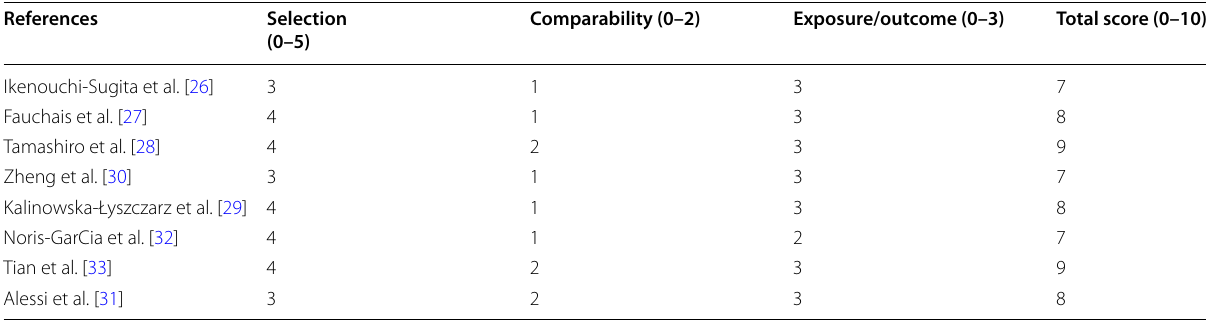
Table 2 Newcastle–Ottawa Scale (NOS) risk of bias assessment of the included studies